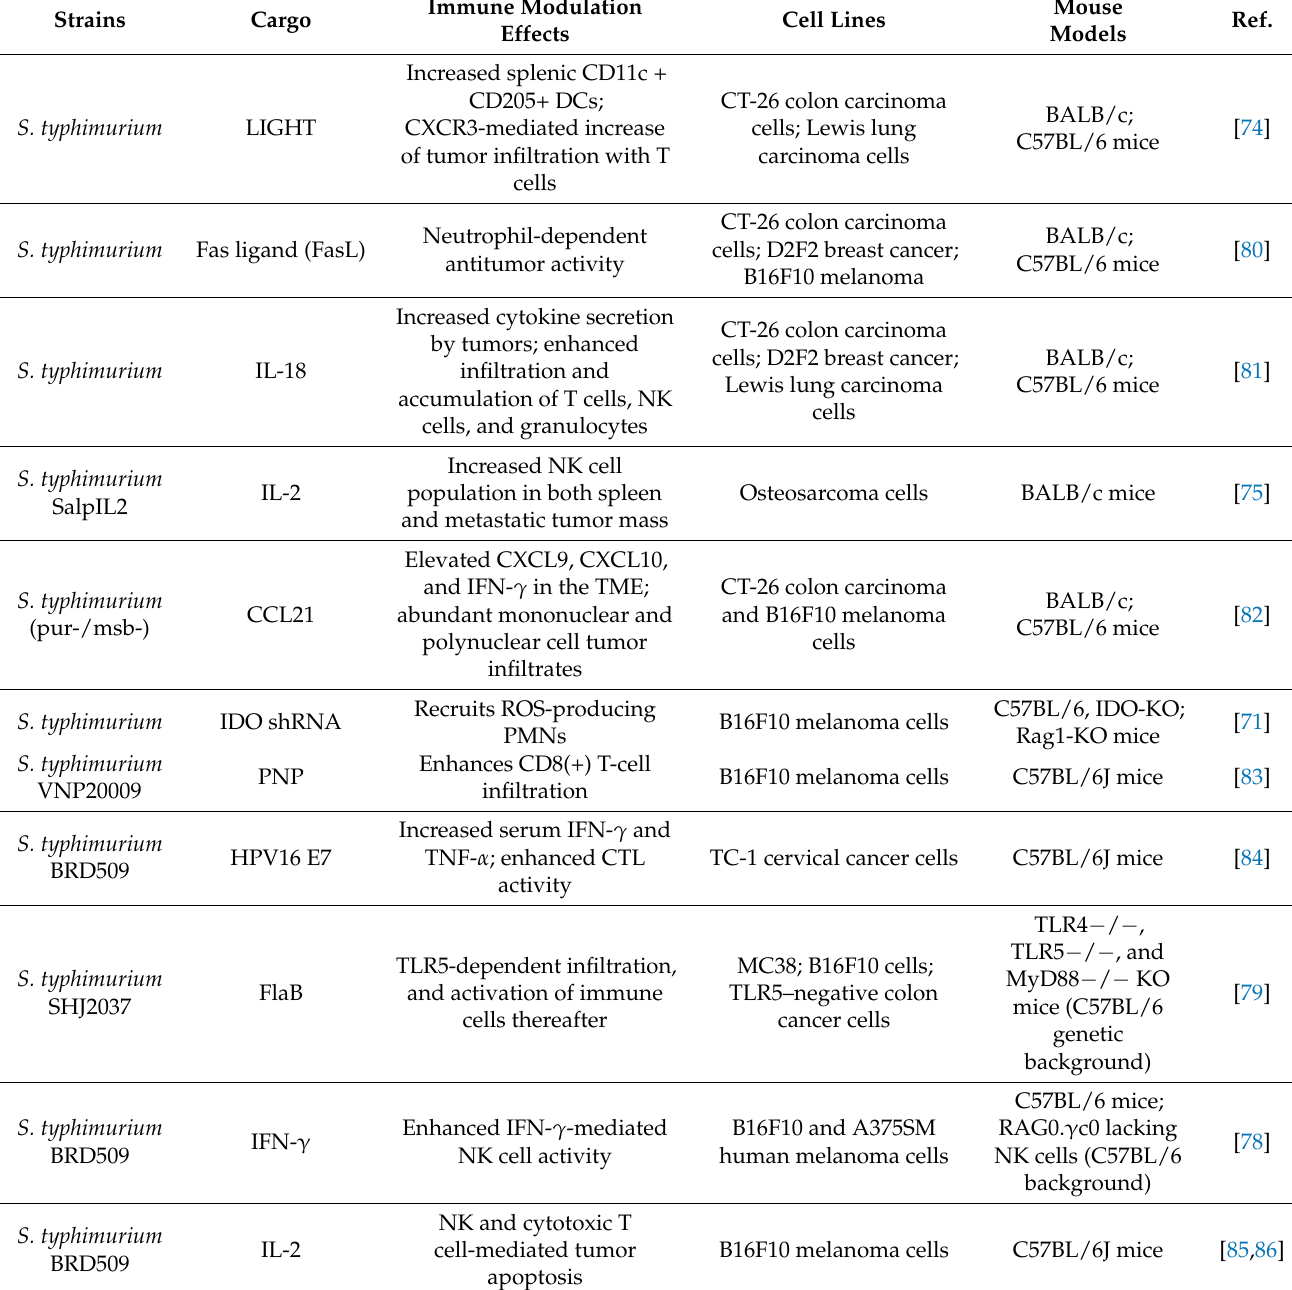
Table 1. Salmonella as a delivery vehicle for cancer